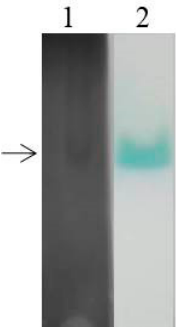
Figure 3. Decolorization percentage of RBBR under three mediators ( a ) and four metal ions ( b ). The